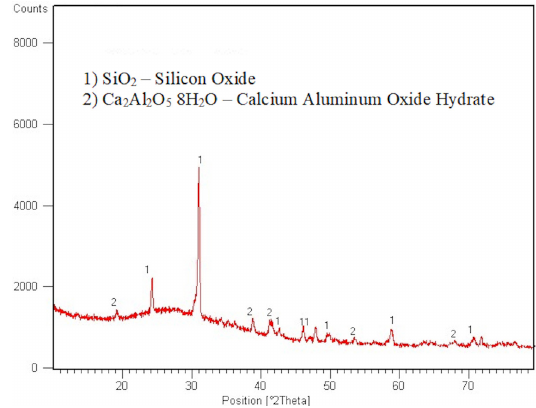
Figure 3. XRD patterns of fly ash